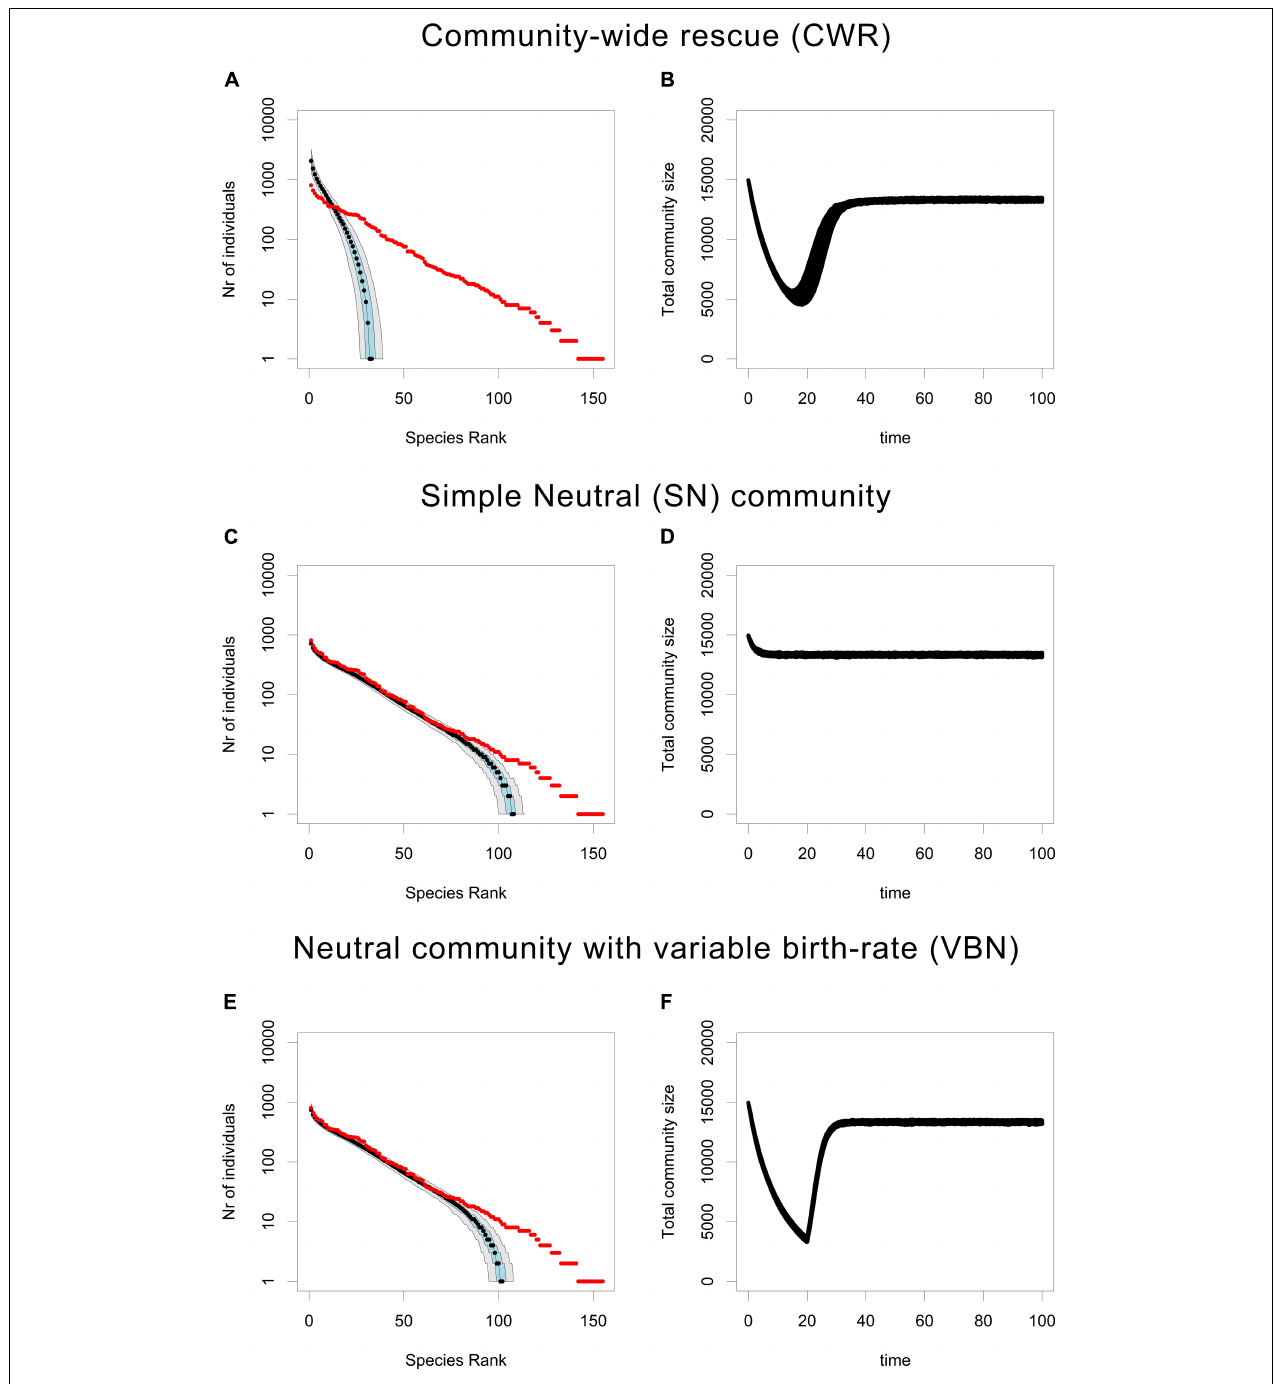
FIGURE 1 | Rank Abundance Curves and total community size under the CWR, SN, and VBN models. (A,C,E) Show the RACs produced after 100 units of time by the CWR model, the SN model and the VBN model, where the median is shown in black, the 25th and the 75th percentile are shown in blue and the 5th and the 95th percentile are shown in gray, the initial community is plotted in red. (B,D,F) Show the accompanying trajectories of total community size for each simulation over time. All plots are based on 500 simulations. Parameters for (A,B) : b 0 , res = 0.05, b 0 , mut = 0.6, d = 0.1, K = 16000, and µ = 0.0005, for (C,D) : b 0 = 0.6, d = 0.1 and K = 16000, for (E,F) : b 0 = 0.05 for t between 0 and 20, b 0 = 0.6 for t between 20 and 100, d = 0.1, and K = 16000.